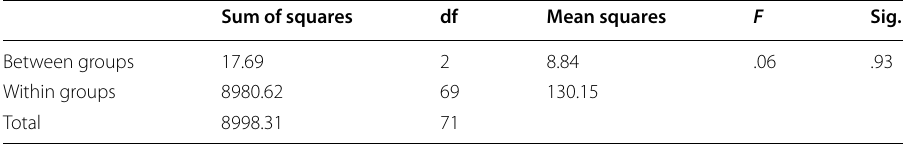
Table 2 Inferential statistics of all groups on the test anxiety pre-tests Sum of squares df Mean squares F Sig. Between groups 17.69 2 8.84 .93 Within groups 8980.62 130.15 8998.31 71